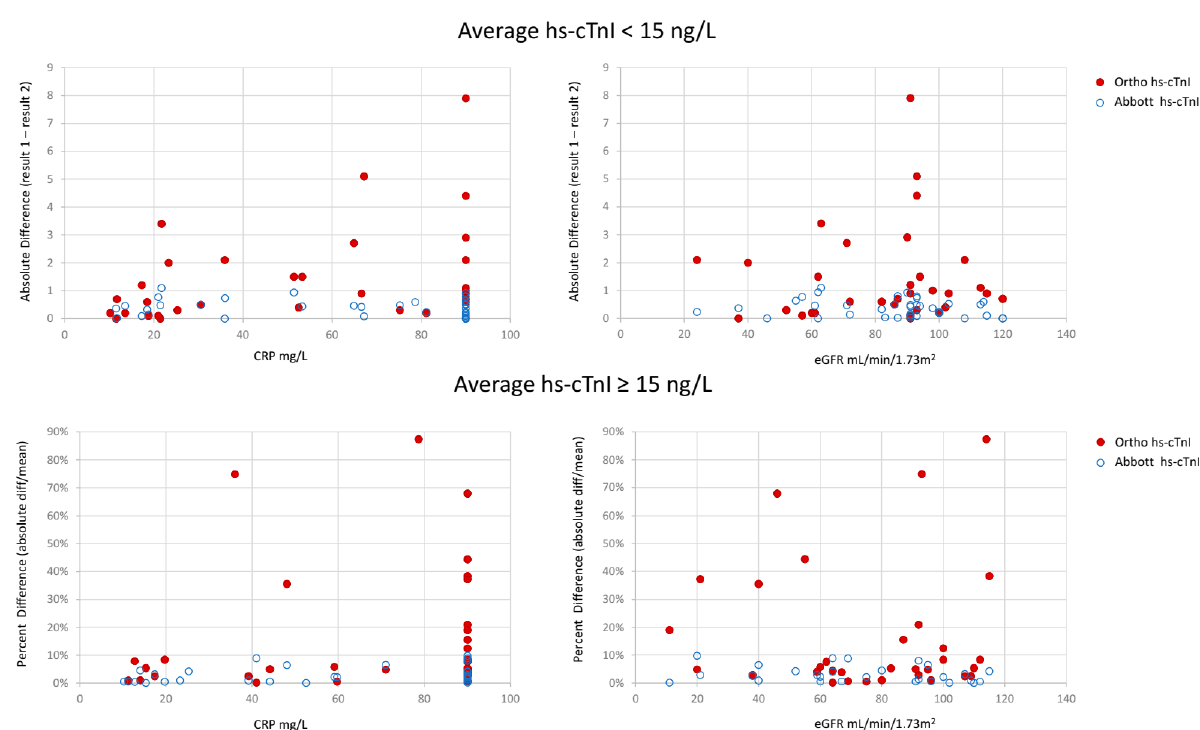
Figure 2. Difference between hs-cTnI repeats for hs-cTnI concentrations below and above 15 ng/L as measured in lithium heparin plasma. The difference between Ortho hs-cTnI results are presented as red full circles and Abbott hs-cTnI results as open blue circles.